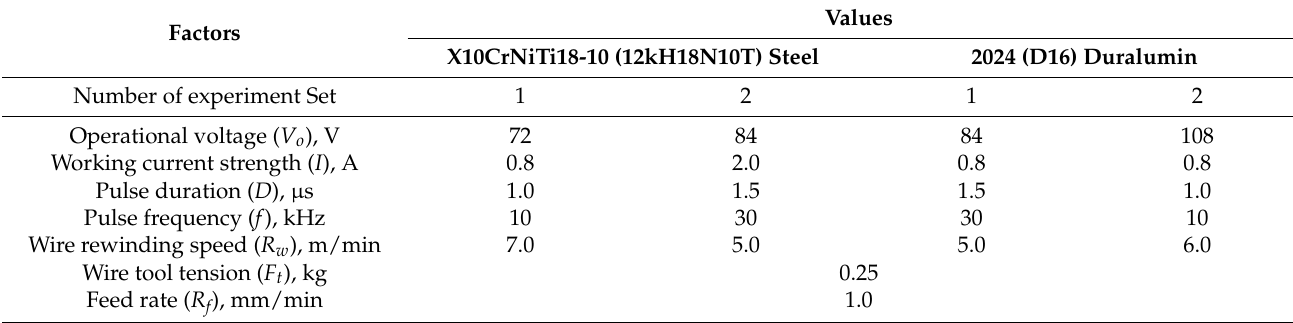
Table 2. Electrical discharge machining factors (ARTA 123 Pro